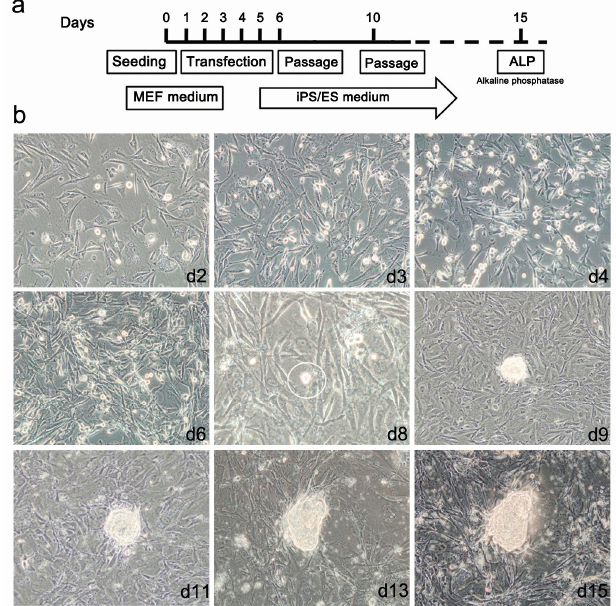
Figure 6. Generation of induced pluripotent stem cells. ( a ) Diagram illustrating the reprogramming protocol used in our experiment; ( b ) The lipofected cells showed changes in their morphology from the fibroblast appearance to round, like that of epithelial cells, which gradually increased in the first 7 days until the appearance of the first small colony-like structure at the 8th day of culture. The colonies subsequently increased in size to form embryonic stem (ES)-like colonies by the 15th day post transfection; (magnification 100×).